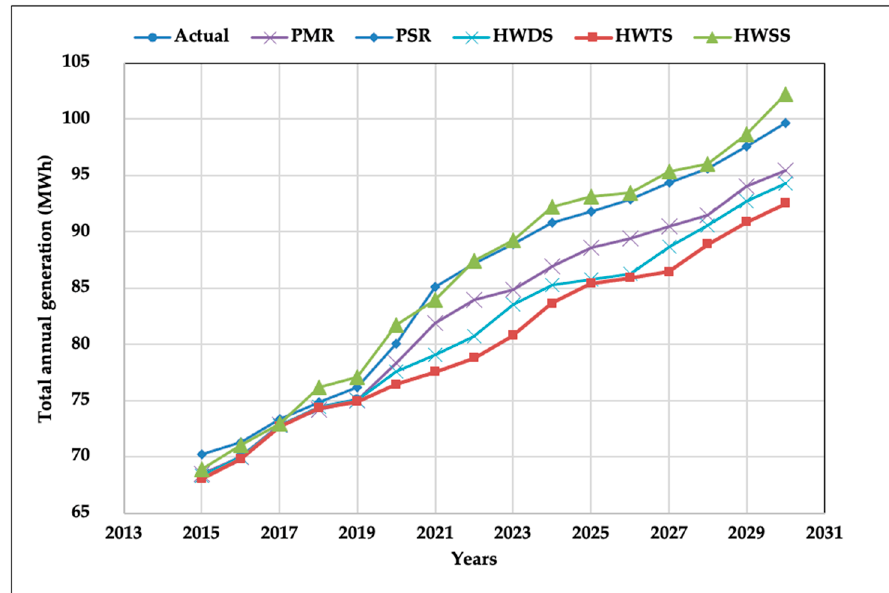
Figure 6. The long-term annual electrical generation forecasting of the five models.